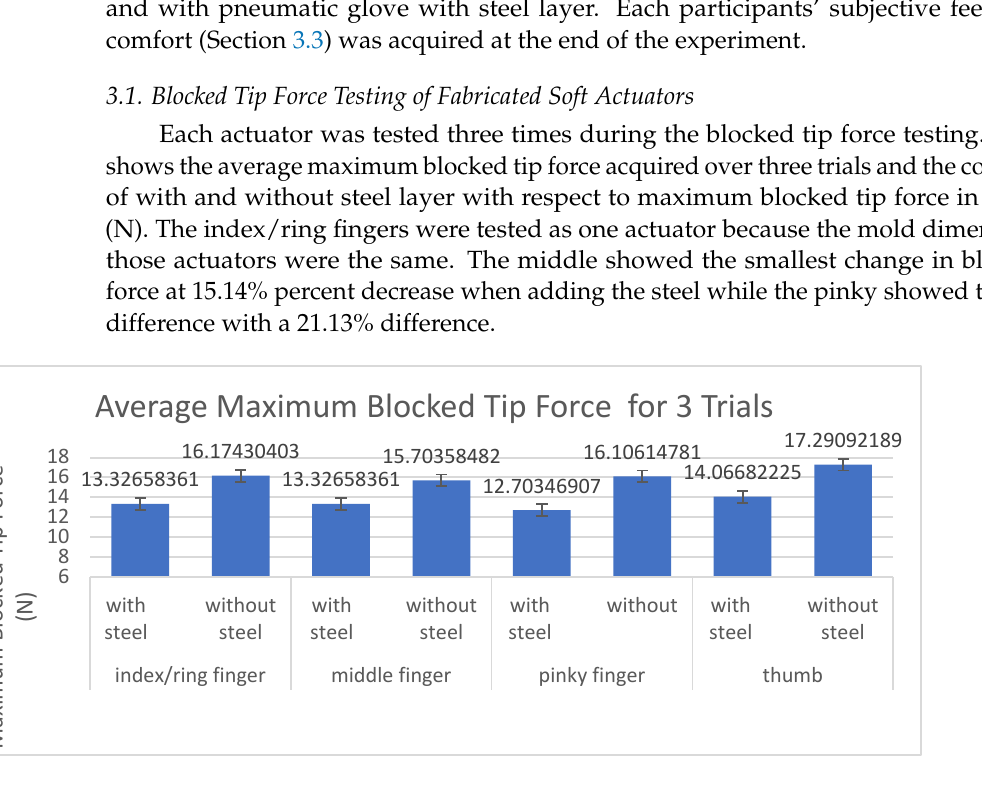
Figure 7. Comparison of blocked tip force per actuator of each finger with and without the layer of stainless flexible steel.